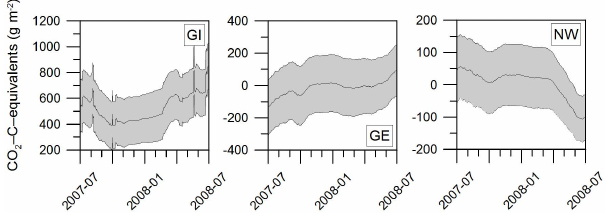
Fig. 5. Annual GWP for 365 days with respect to a shifting period of time. The x-axis shows the start date of the respective integration period. The shaded area displays the cumulated standard deviation, which is calculated as the sum of the daily standard error of R ECO and GPP models and the standard error of the CH 4 /N 2 O emission